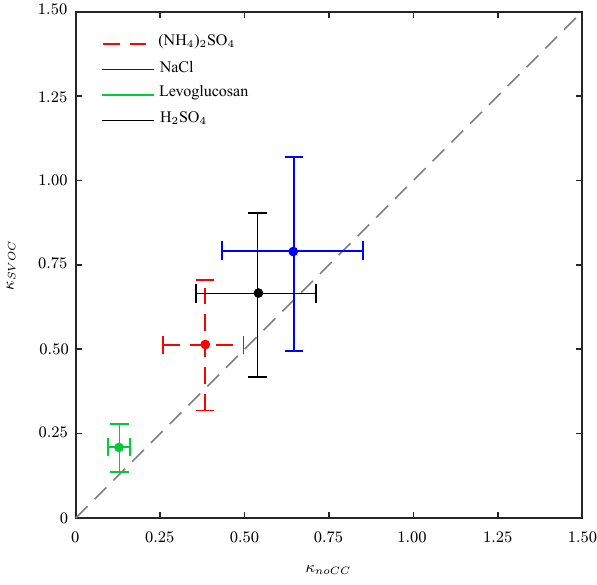
Figure 5. Hygroscopicity, κ SVOC plotted against κ noCC . The grey dashed line shows equality between the axes, error bars showing the middle 67% of our derived values and the intersections of the error bars depicting the means. Ammonium sulfate is shown in red with dashed error bars, sodium chloride is shown in blue, levoglucosan is shown in green and sulfuric acid is shown in